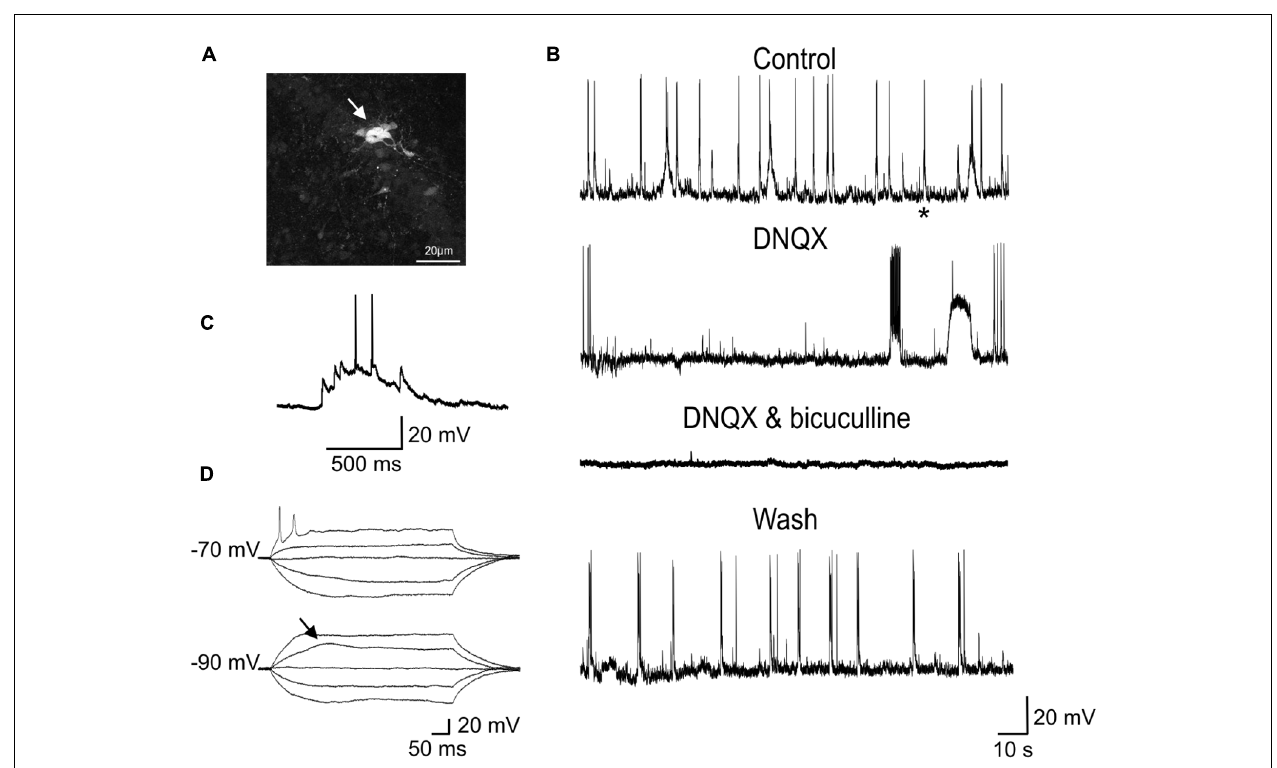
FIGURE 7 | Network-driven GDPs were reduced in frequency by DNQX and blocked by DNQX plus bicuculline. (A) Whole-cell recording of a P2 GC with biocytin revealed a cluster of several dye-coupled neurons. (B) Sample traces of spontaneous activity (GDPs) recorded from the same neuron in control conditions, in DNQX (20 μ M), in DNQX and bicuculline (20 μ M) and after wash. In the presence of